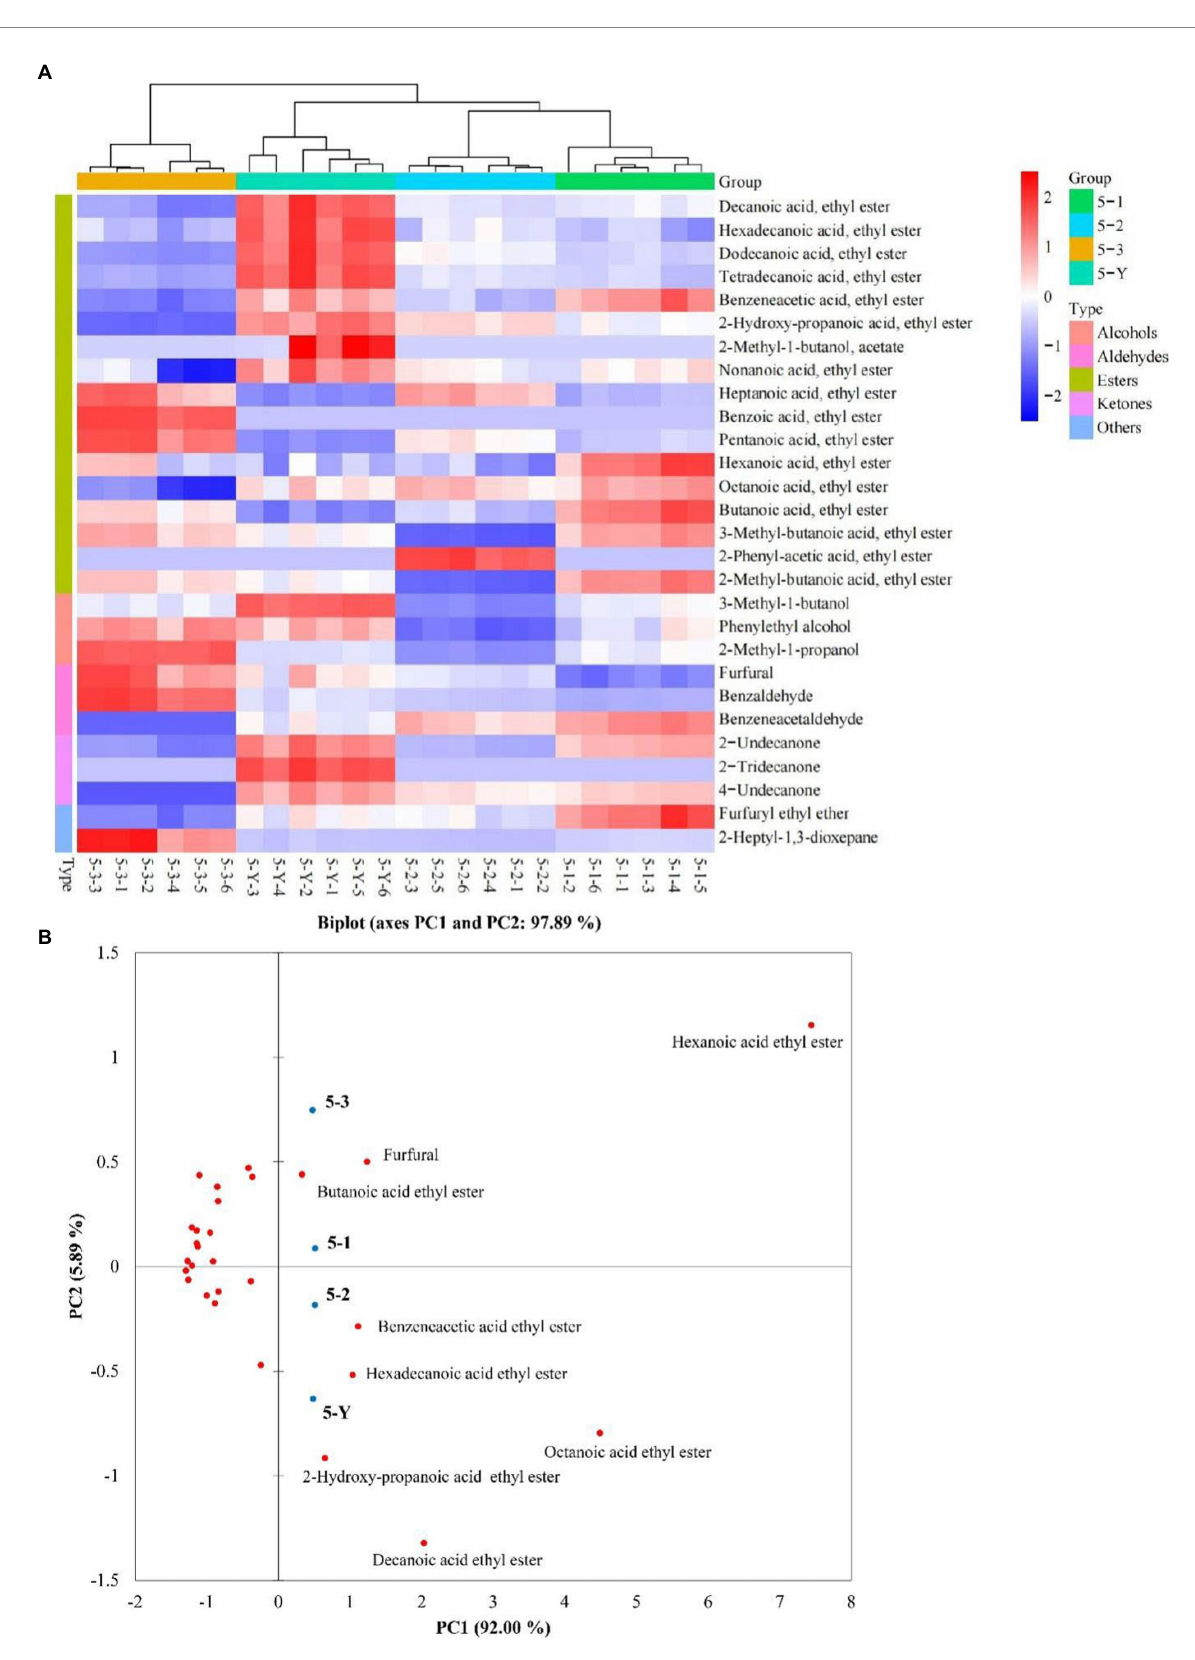
FIGURE 8 Heatmap (A) and principal component analysis (PCA) biplot (B) of differential compounds in different quality grades of base liquor of 5th round of